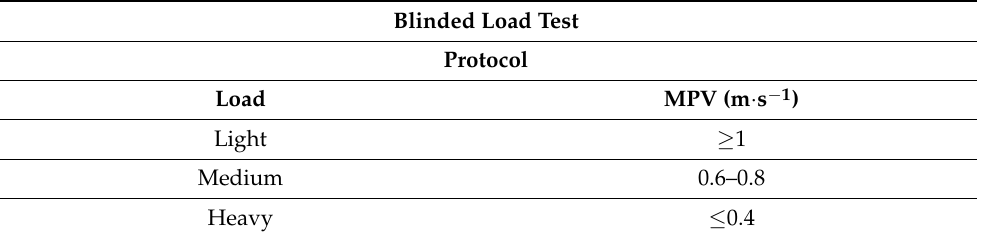
Table 2. Blinded load test during the Perception of Velocity testing